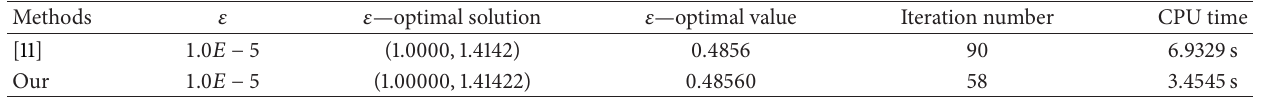
Table 1: Computational results of Example 12.